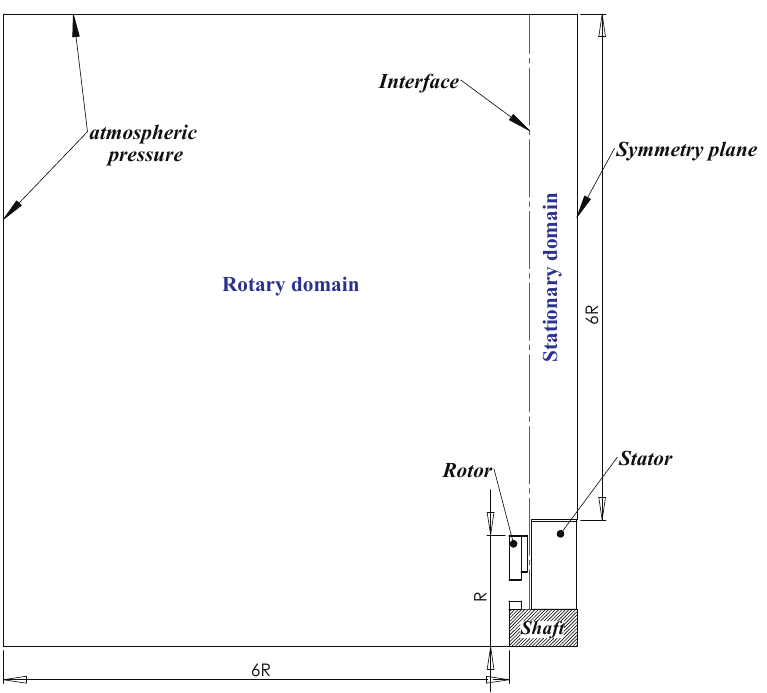
Figure 2. Side view of the computational